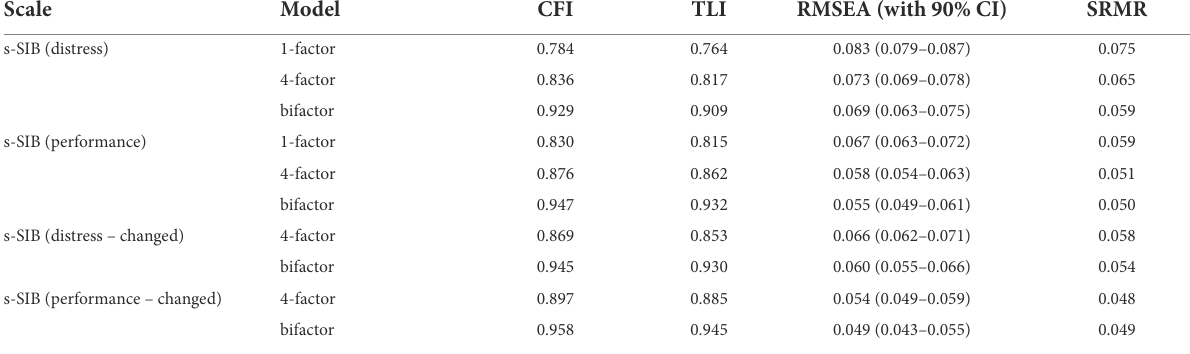
TABLE 4 Fit indices for s-SIB (distress and performance) models.